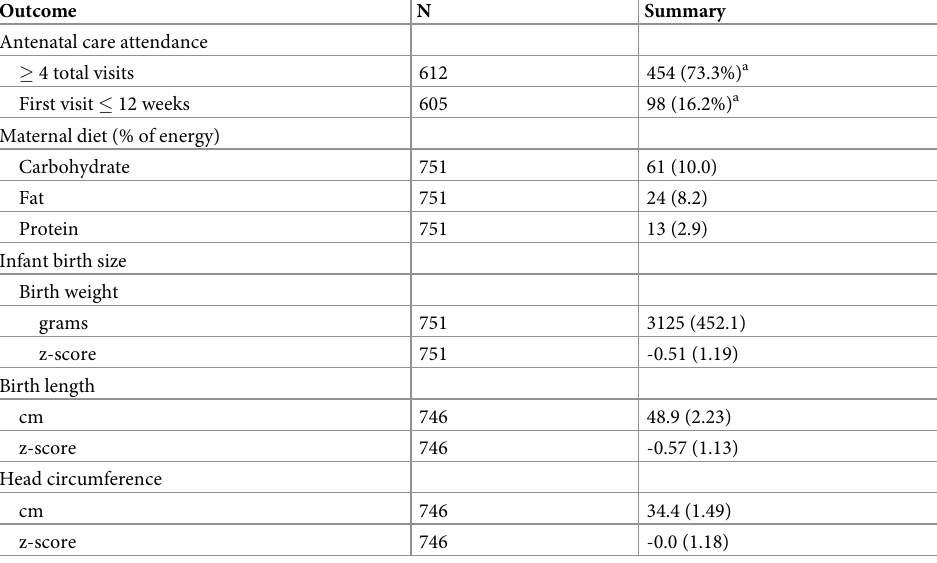
Data are presented as mean (SD) for continuous measures, and n (%) for categorical measures. a . Percentages adjusted using inverse probability of censoring weighting to account for missing